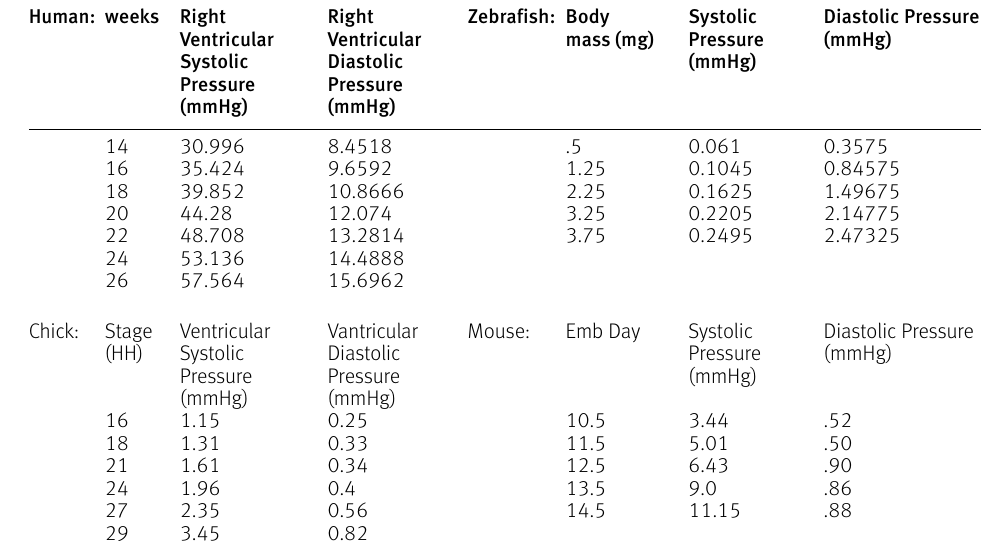
Table 3. Blood Pressure across developmental animal models. Adapted from [114–117]. Human: weeks Right